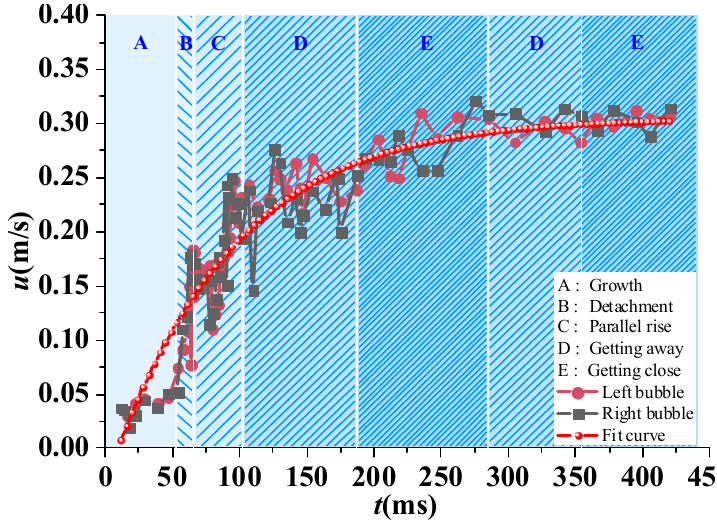
Figure 7. Longitudinal velocity versus time.